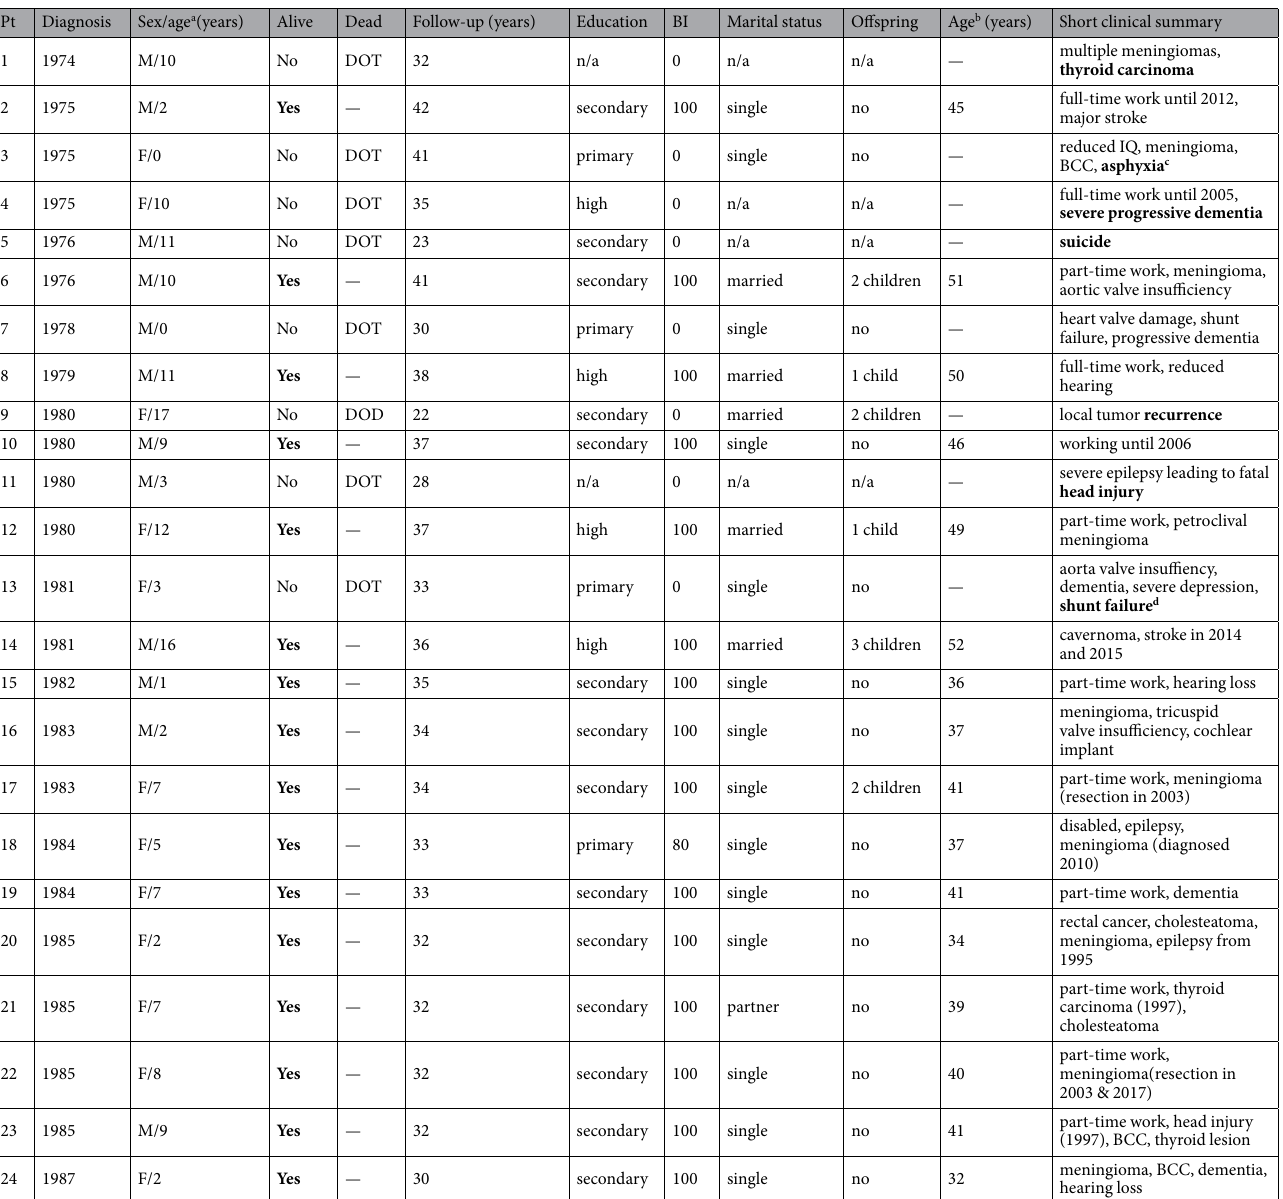
Table 1. Patients surviving > 20 years following primary treatment for posterior fossa MB in childhood. In those who died during the follow-up, the documented or supposed cause of death (whenever known) is marked in bold letters in short clinical summary. BCC = basal cell carcinoma, BI = Barthel Index, DOD = dead of disease, DOT = dead of (late effects of) treatment. n/a = information not available a age at diagnosis b age at the latest follow-up c this patient developed swallowing difficulties and finaly died from suffocation, after having aspirated a piece of meal and being resuscitated d this patient with dementia and severe depression progressively deteriorated the last half year of her life due to heart failure; when she in addition developed a shunt failure, the family did not wish a surgical exploration of her shunt. It was respected and regarded as a palliative measure, in order to prevent the patient from further